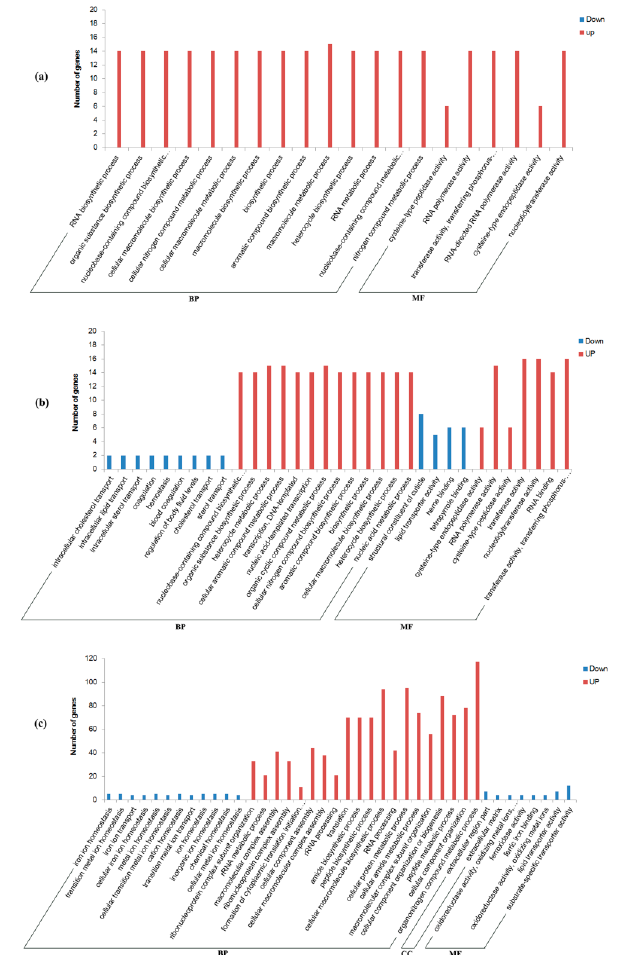
Figure 4. GO enrichment of DEGs in Mated-1 h vs. Virgin-1 h group ( a ), Mated-6 h vs. Virgin-6 h group ( b ), and Mated-24 h vs. Virgin-24 h group ( c ). The function of DEGs was divided into three parts: BP (biological process), CC (cell composition), and MF (molecular function). The red bars indicate upregulated DEGs and blue bars indicate downregulated DEGs. The top 20 terms each from upregulated DEGs and downregulated DEGs of each group are shown.